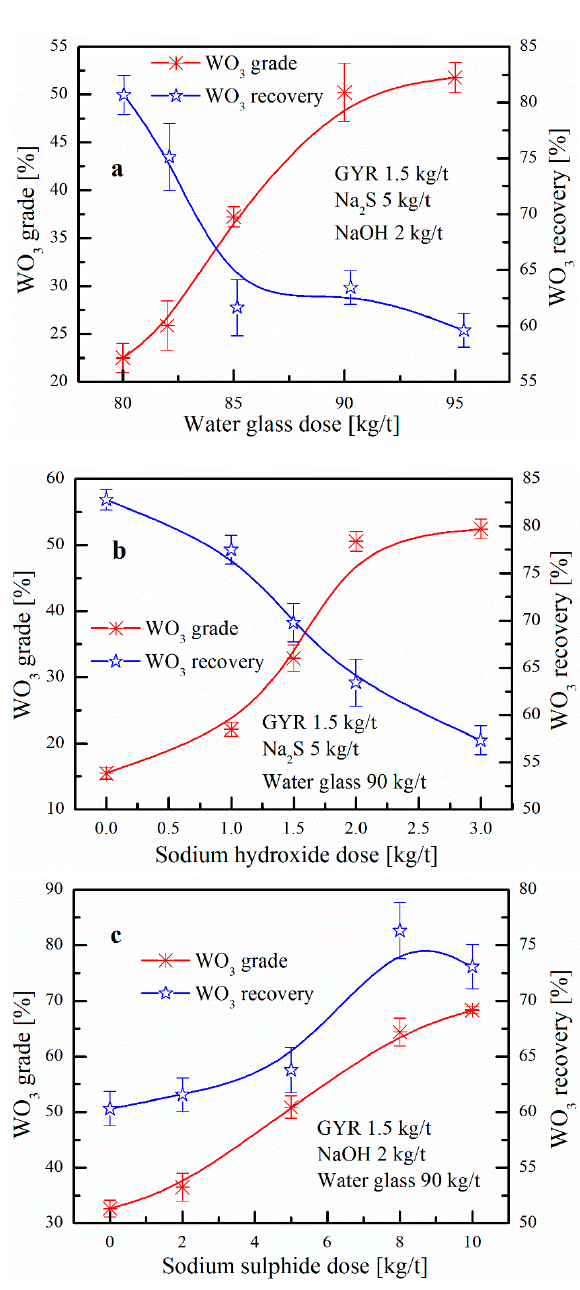
Figure 3. Scheelite heating flotation with water glass ( a ), sodium hydroxide ( b ) and sodium sulfide ( c ).